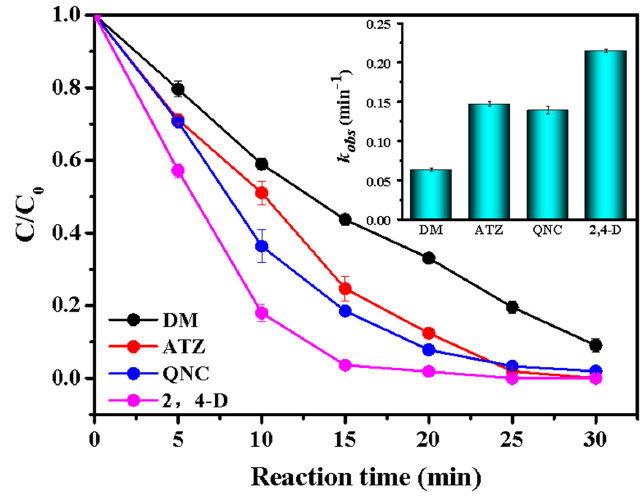
Figure 8. The application of schematic diagram of mass production of E/Fe–N–BC catalyst for the removal of different organic pollutions in the presence of PMS. Reaction condition: [catalyst] = 0.3 g/L, [PMS = 0.8 mM], T = 25 ± 1 °C, [DM] = [ATZ] = [QNC] = [2,4–D] = 10 mg/L.